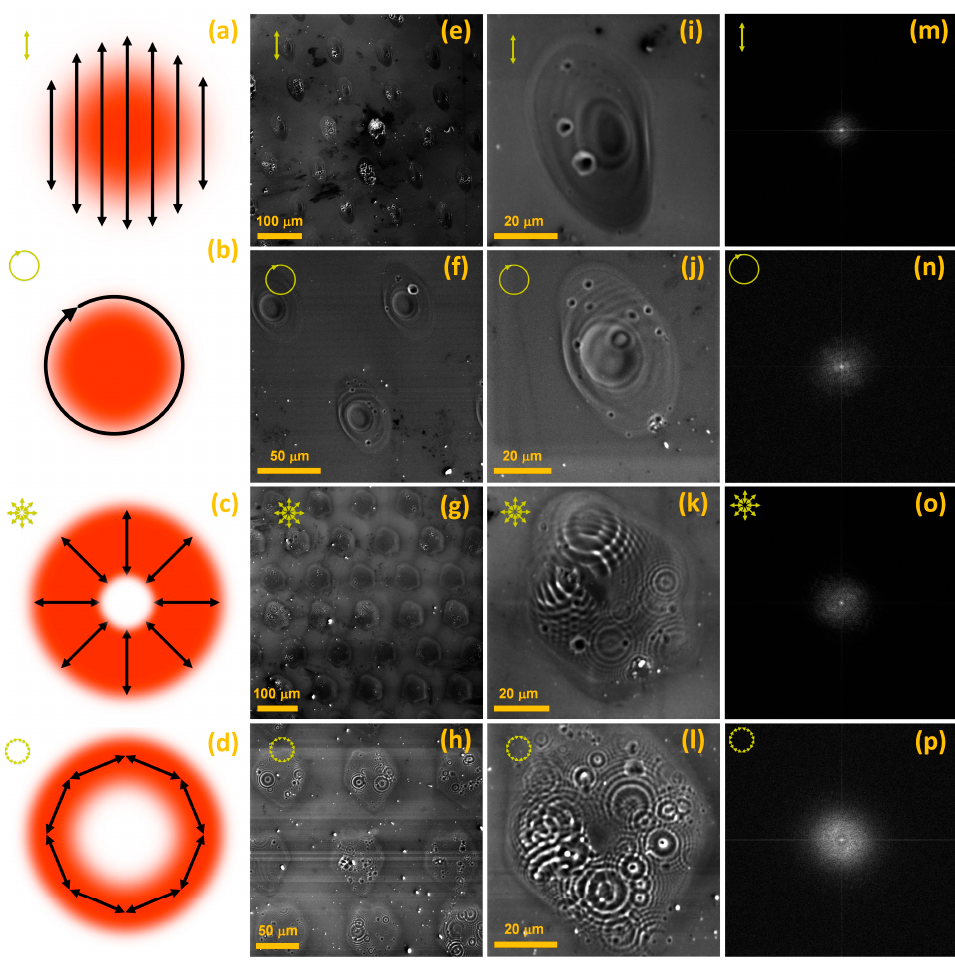
Figure 5. Visualization of the spatial distribution of fluence/electric field of the ( a ) incident linearly polarized Gaussian beam, and its subsequent conversion to ( b ) circularly ( c ) radially and ( d ) azimuthally polarized beams. SEM micrographs of an array of spot areas on Si modified by ( e ) linearly ( f ) circularly ( g ) radially and ( h ) azimuthally polarized single pulses. SEM micrographs of isolated spot area on Si modified by ( i ) linearly ( j ) circularly ( k ) radially and ( l ) azimuthally polarized single pulses. ( m – p ) represent the corresponding 2D Fourier transforms of ( i – l